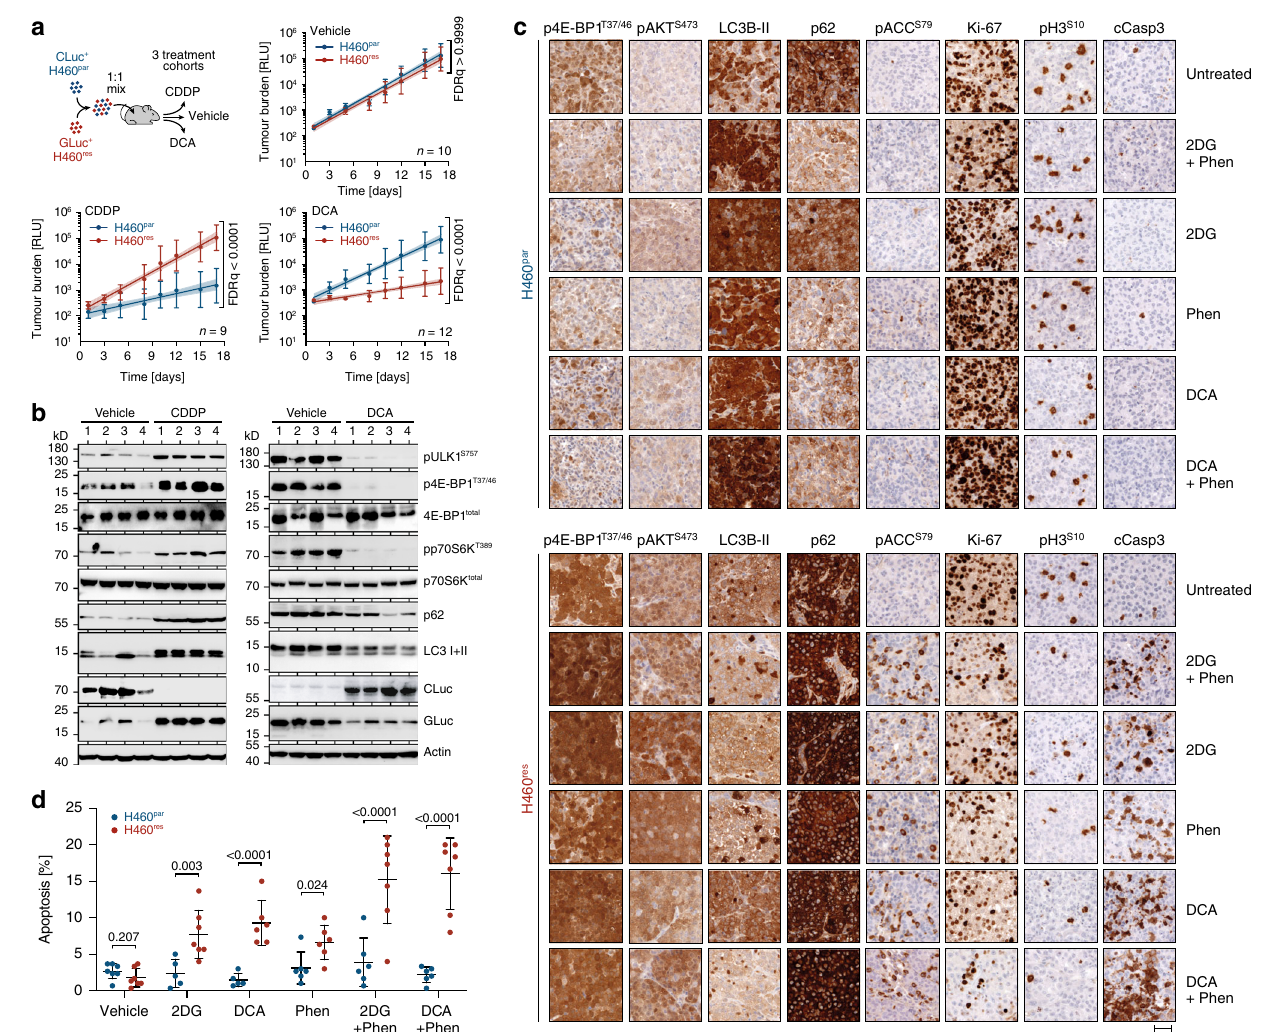
Fig. 7 Metabolic inhibitors selectively target CDDP-resistant cancer cells in vivo. a , b Mice were subcutaneously injected with a 1:1 ratio of H460 par and H460 res cells labeled with the secreted luciferases GLuc and CLuc, respectively, and treated as indicated. Tumor burden was quanti fi ed separately for each cell type by longitudinal luciferase activity measurement in blood samples. a Tumor growth curves show the tumor burden over time as mean ± SD and a linear regression curve with 95% CI, FDR q values. b Western blot of four tumors from each mouse cohort in a . c , d H460 par and H460 res cells were injected intravenously into immunode fi cient mice. Developing tumors were treated with the indicated drugs for 3 days. Tissue sections were immunostained for the indicated proteins. Shown are representative images of tumors from each treatment cohort. Scale bar, 40 µ m. d Quanti fi cation of apoptotic index (cleaved caspase-3) from n = 100 cells in three fi elds of view/mouse. Shown is the apoptotic index for individual mice, mean ± SD, FDR q